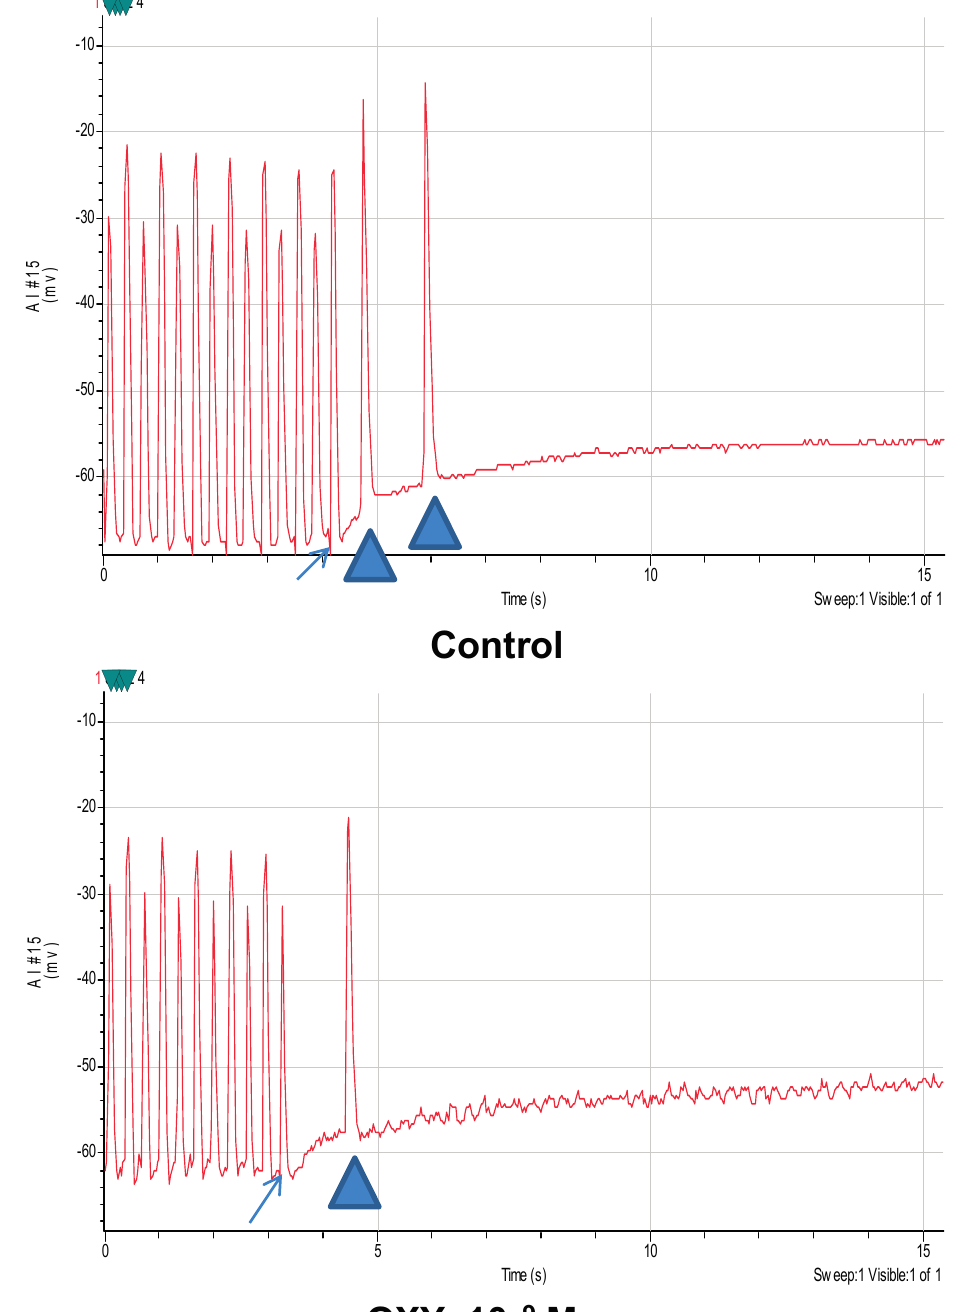
Figure 3. Four panels showing paced action potentials, with the last marked by arrows, induced delayed after-depolarization mediated triggered activity marked with triangles. Top panel : Baseline; Second panel : Superfused with oxypurinol 10 − 9 M; Third panel : Superfused with oxypurinol 10 − 8 M; and Fourth panel : After wash. Oxypurinol blocks TA at 10 − 8